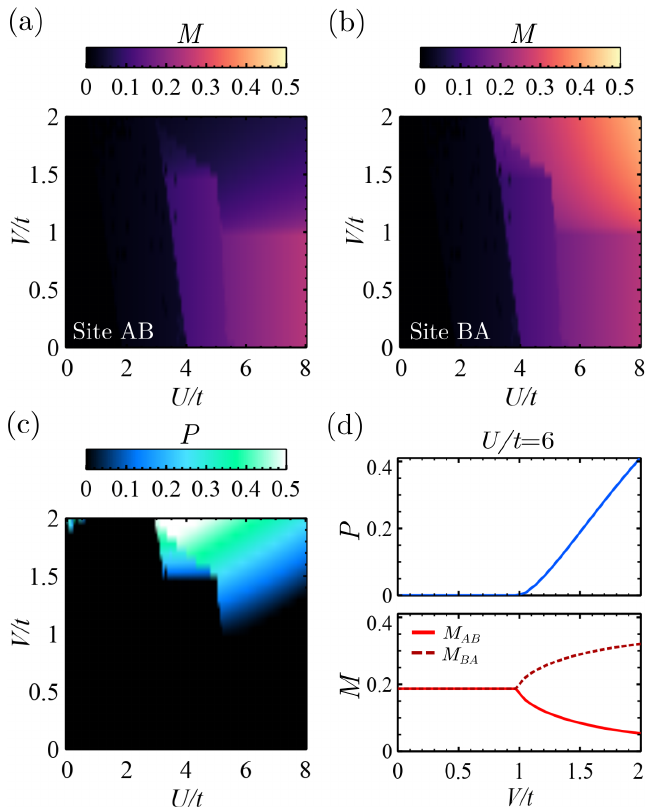
Figure 2: Emergence of the multiferroic order. (a,b,c) Phase diagrams as a function of the on-site U and first neighbor V Coulomb interactions for the different order parameters defined in the text: Magnetization M on sites AB (a) and BA (b), and electric polarization P (c). Magnetization is promoted by U interactions, and V in- teractions promote a sublattice imbalance that generates a finite electric polarization. A ferrimagnetic phase and a fully gapped charge density wave coexist in the top-right region of the phase diagram. This multiferroic behavior can be better seen in a cut at U / t = 6. (d) Order parameters as a function of V / t for U / t = 6, P ( M ) in the top (bottom) panel. For V / t > 1 both order parameters present a finite value and the magnetization on each site becomes